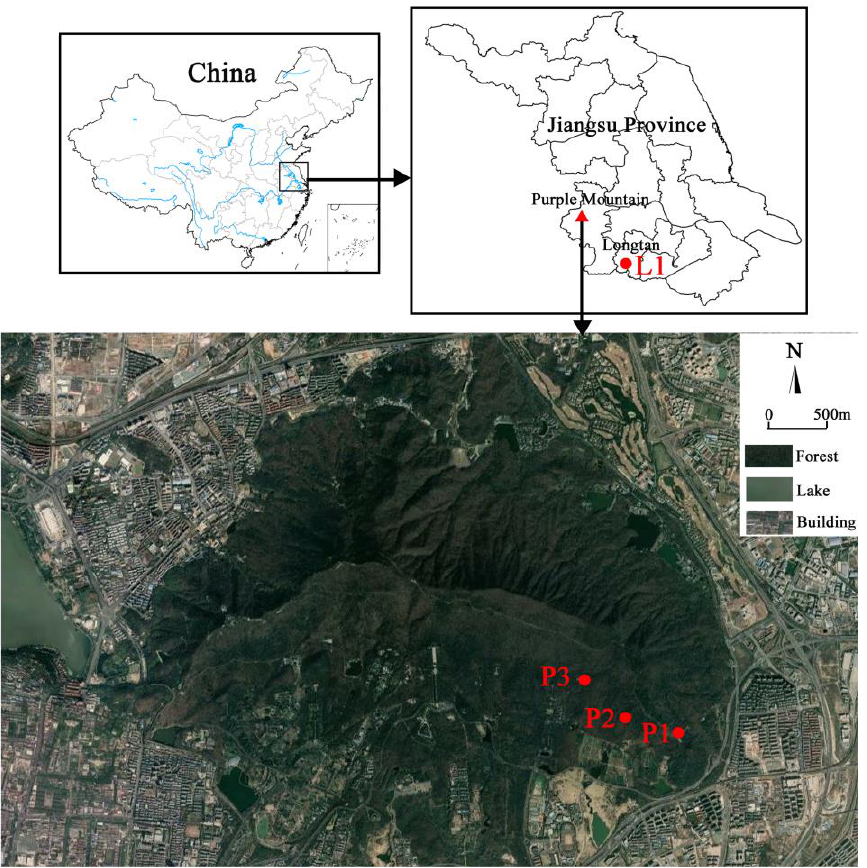
Figure 1. Location of the study area showing one pure pine forest (labelled as L1) in Longtan, Liyang and three mixed forests (P1, P2 and P3) in Purple Mountain, Nanjing, within southern Jiangsu Province, China.